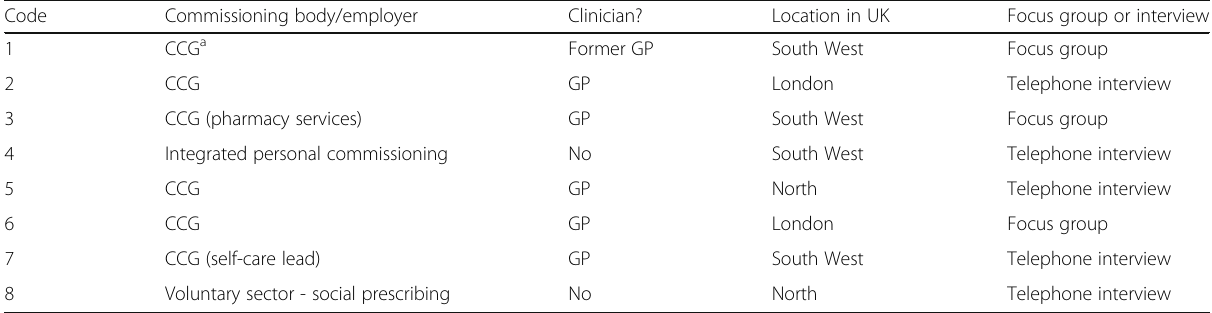
Table 3 Participants in commissioner focus groups/interviews